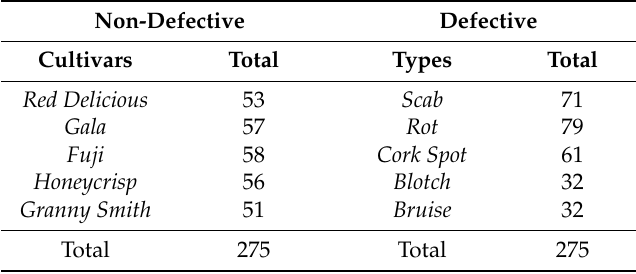
Table 1. Details of the characteristics in apple